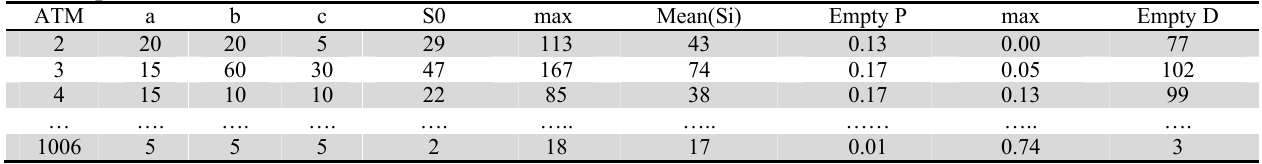
The Optimal Simulation Results for Each